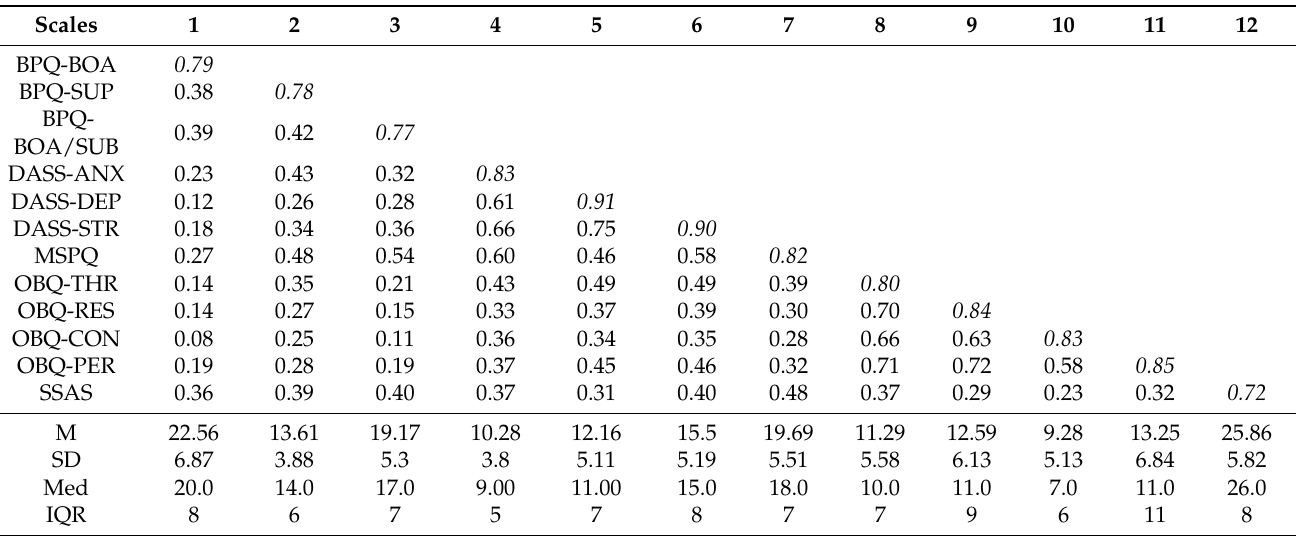
Table 6. Spearman correlations among body perception questionnaire (BPQ)-22 scales and the other measures employed in this study (data from the whole sample, n = 1361).